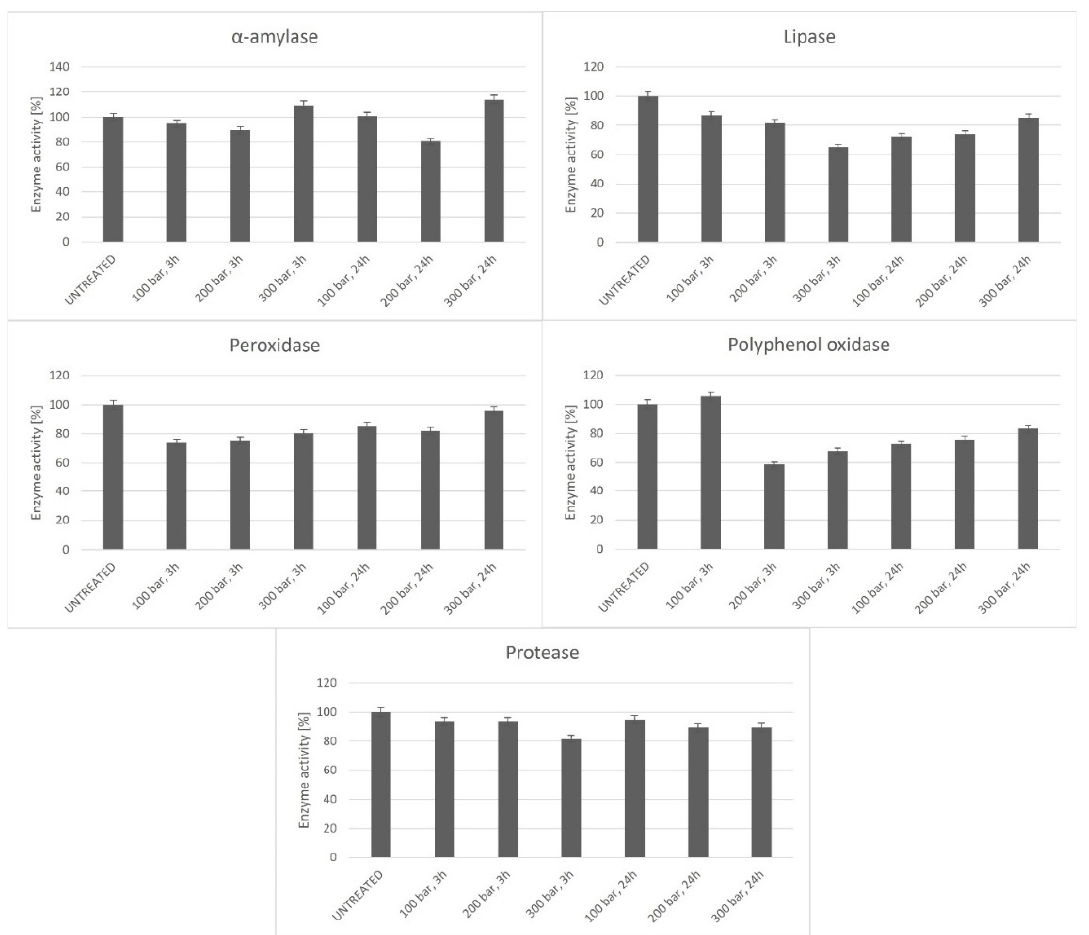
Figure 2. The effect of scCO 2 on enzyme activity in spelt flour. Data represent mean ± SD of three independent experiments. Means among each set of data labelled by the exposure conditions were not significantly different ( p < 0.05) by Duncan’s multiple range test.